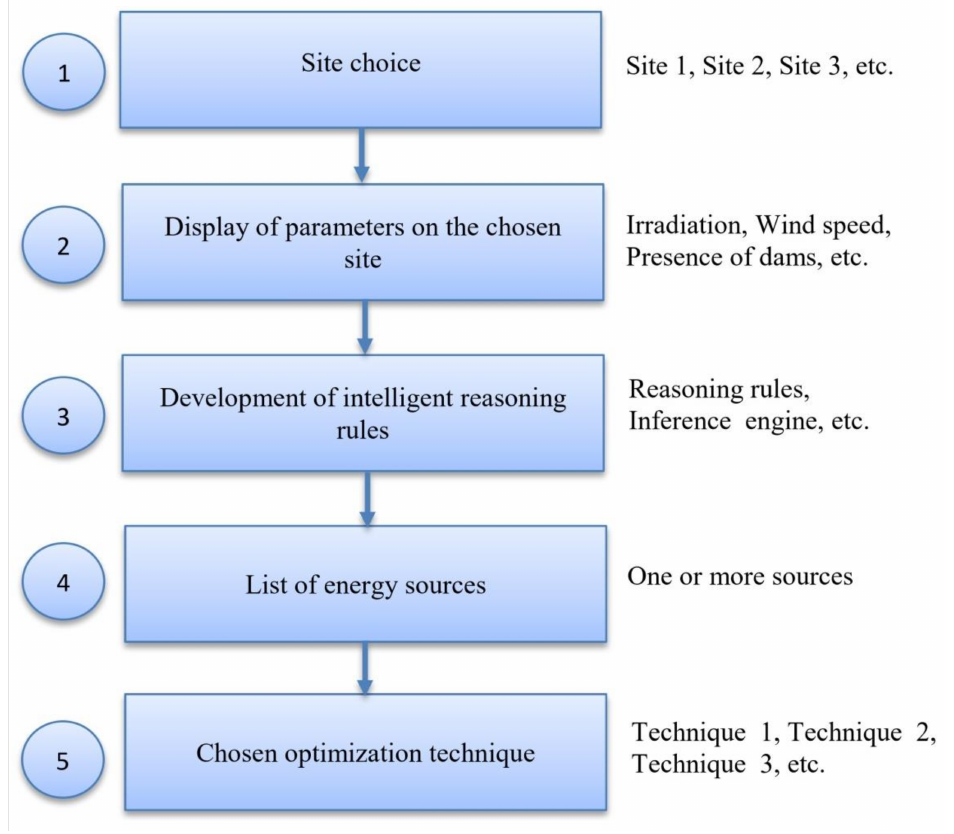
Figure 1. Proposed solution